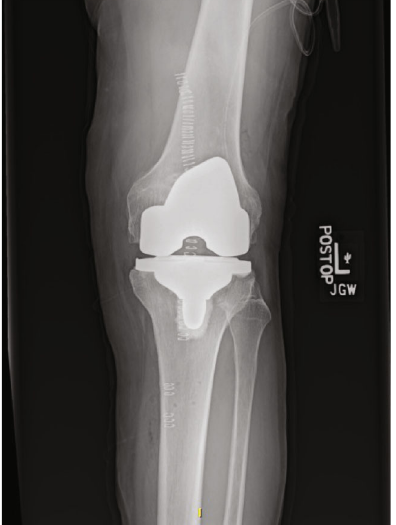
Figure 4: Postop AP TKA X-ray.